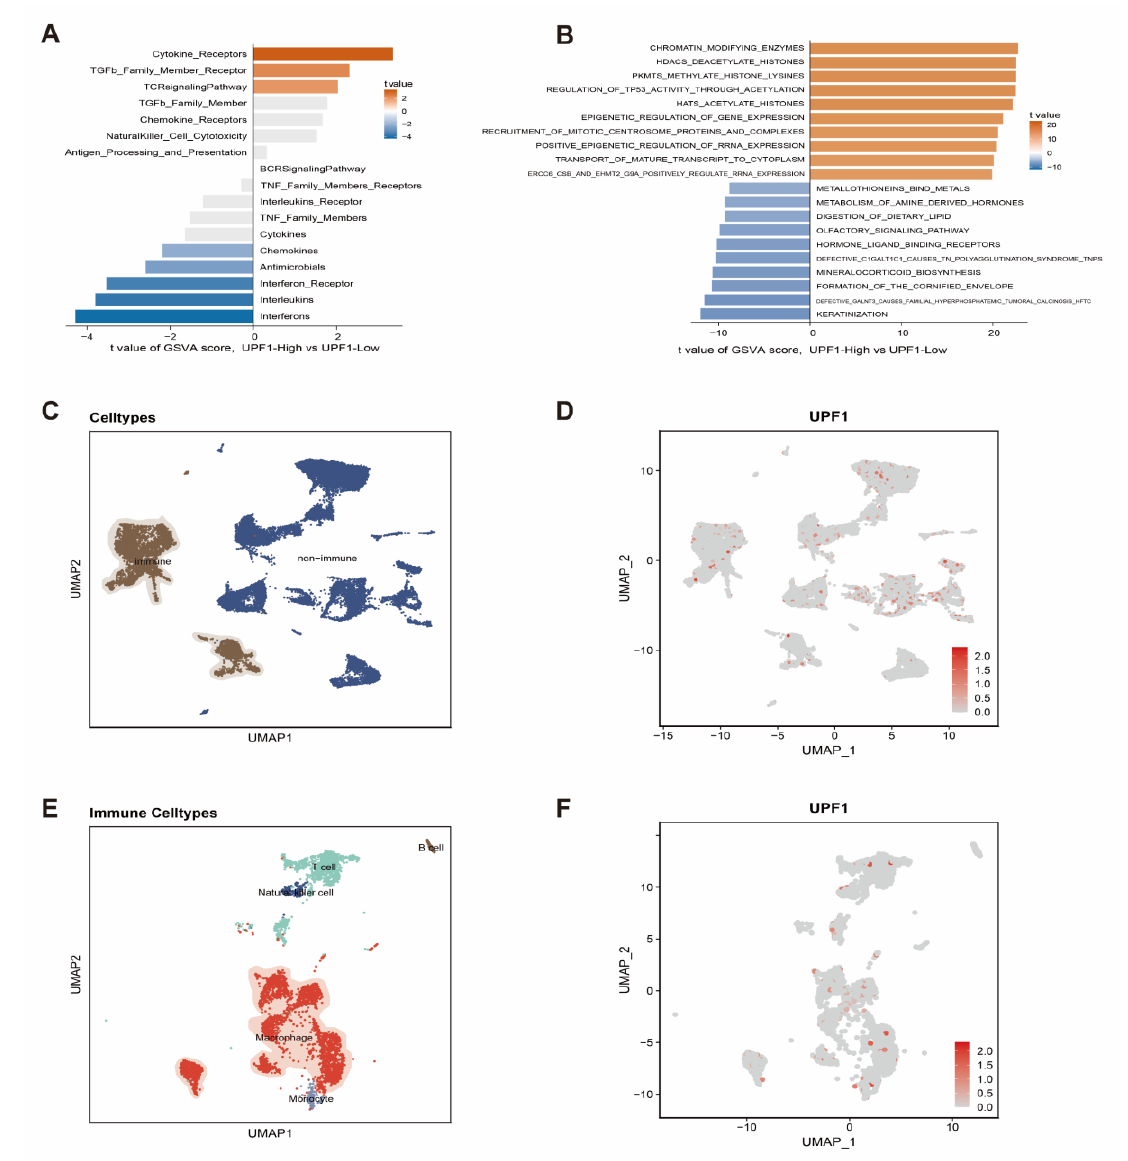
Figure 4. ( A ) Comparing high-UPF1 and low-UPF1 groups in terms of pathway enrichment. ( B ) Comparing high-UPF1 and low-UPF1 groups in terms of Reactome pathway enrichment. ( C–F ) Immune cell type-specific expression of UPF1 in ccRCC.